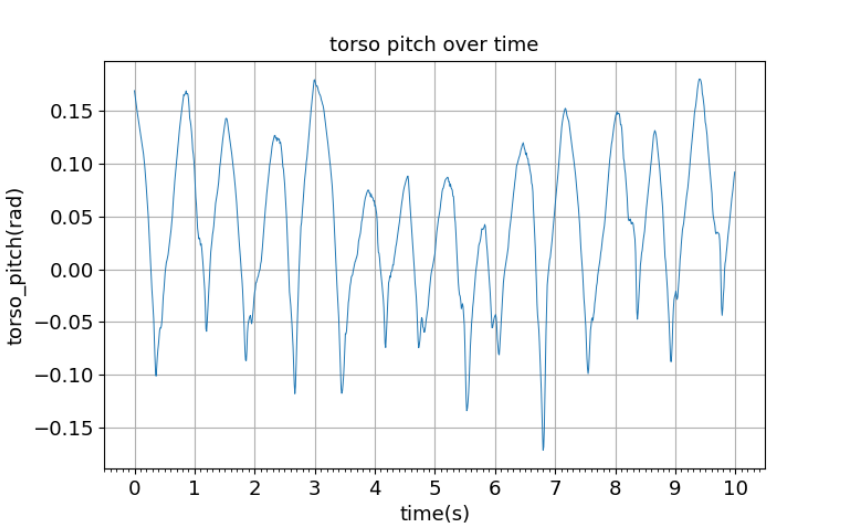
Figure 10. Torso pitch angle during